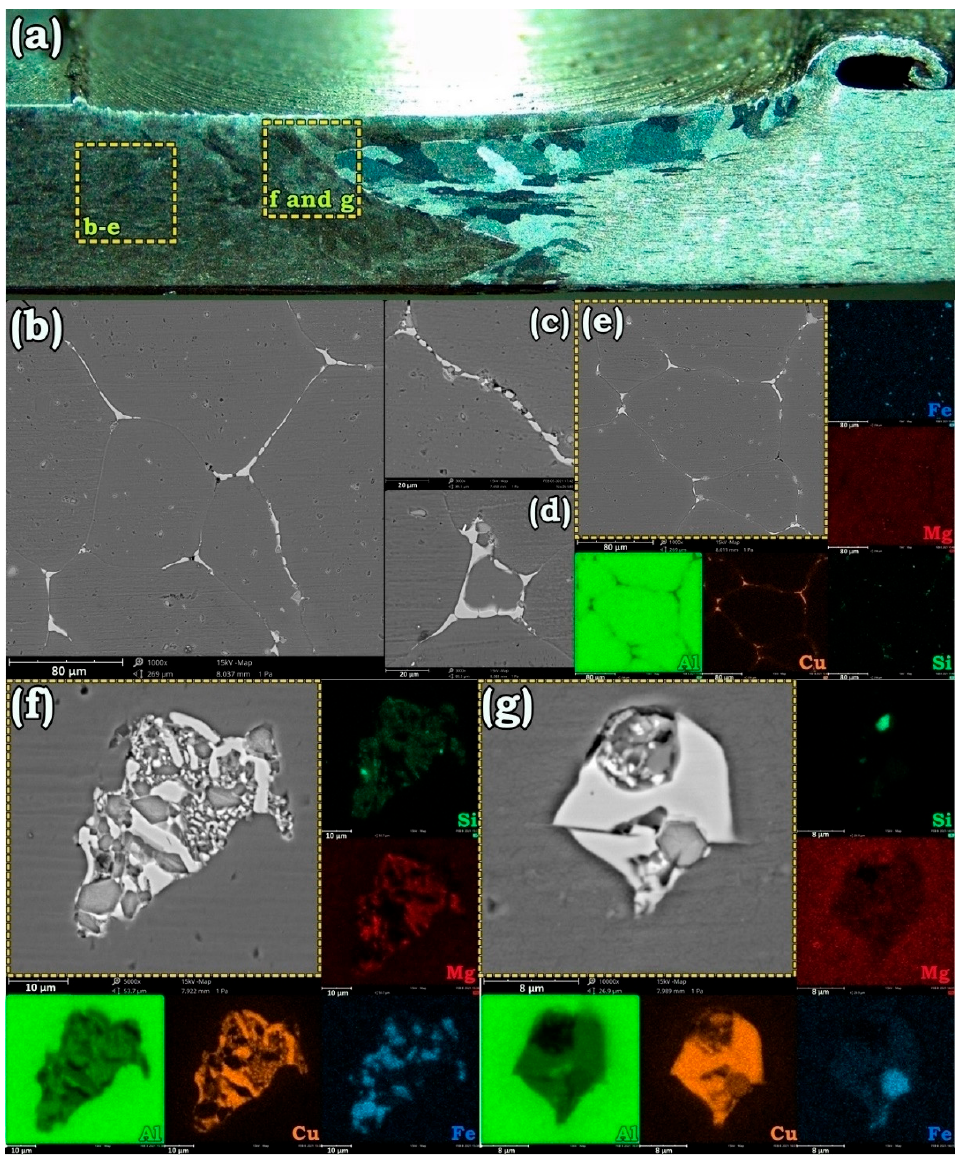
Figure 7. Stereo micrograph of solution treated AA6013-AA2198 weld specimen ( a ) and SEM micrographs showing the morphology of particles in the the base metals (BM), the heat-affected zone (HAZ) ( b – e ), and SZ ( f , g ). along with elemental distribution maps. To find the origin of intergranular failure after annealing at 580 °C, occupied bound- aries with migrated elements were analyzed by microscope and the results are presented in Figure 8. According to Figure 8a,b that are taken from the failure edge of the AA7475- AA2198 joint, GBs were filled with a Cu-rich eutectic phase in addition to coarse polygo- nal Zn- and Mg-rich particles. According to the SEM micrographs in Figure 8c–h, similar accumulation of the solute elements including Si and Fe occurred at the welding interface of AA6013-AA2198 after annealing at 580 °C. The formation of such massive particles made the weakened GBs by the Cu-rich phases more unstable than before. As a result, even thermal shock and solidification contraction of the molten phases at GBs during air cooling could overcome the weak bonding adhesion between the grains and eventuate in the failure of the joint.